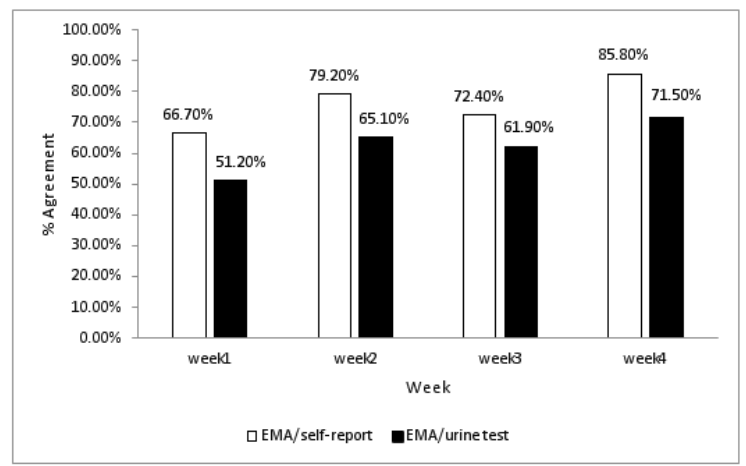
Figure 3. The concordance of test results.